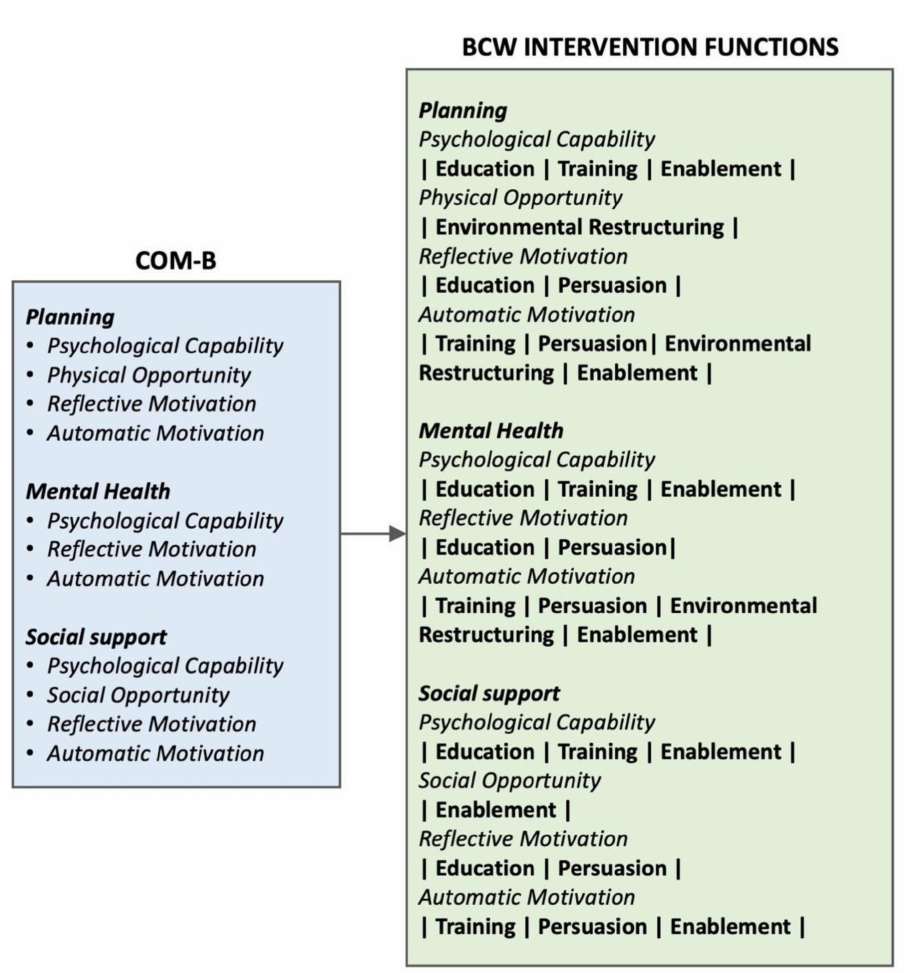
Figure 9. Mapping barriers to intervention